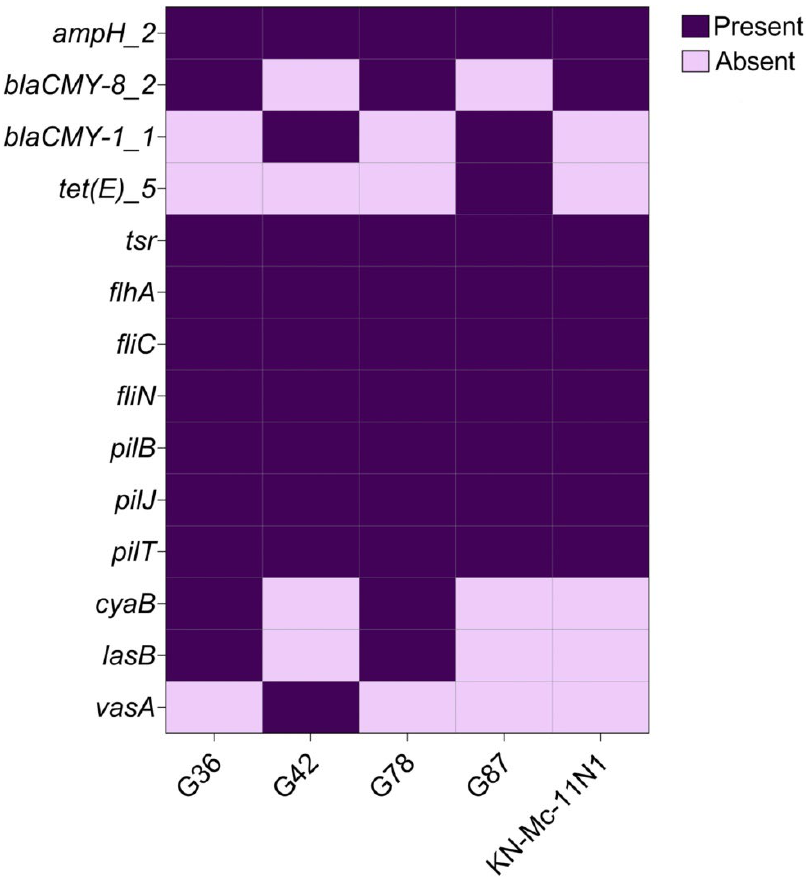
Figure 4. Heat map showing the antibiotic resistance and virulence genes detected among the 4 sequenced and the compared A. rivipollensis strain KN-Mc-11N1.